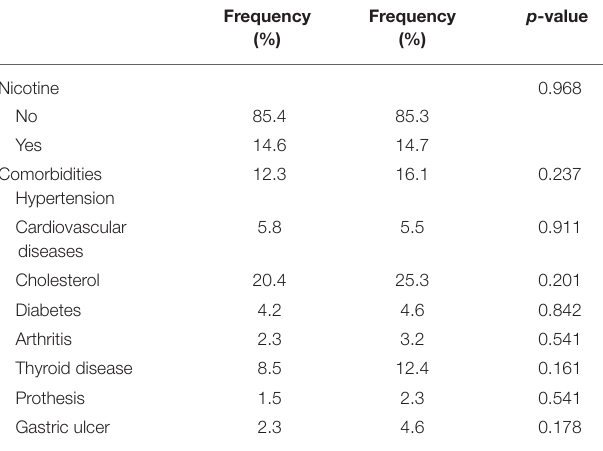
TABLE 2 | Mental health, cognitive reserve and psychosocial factors in no pain and chronic pain